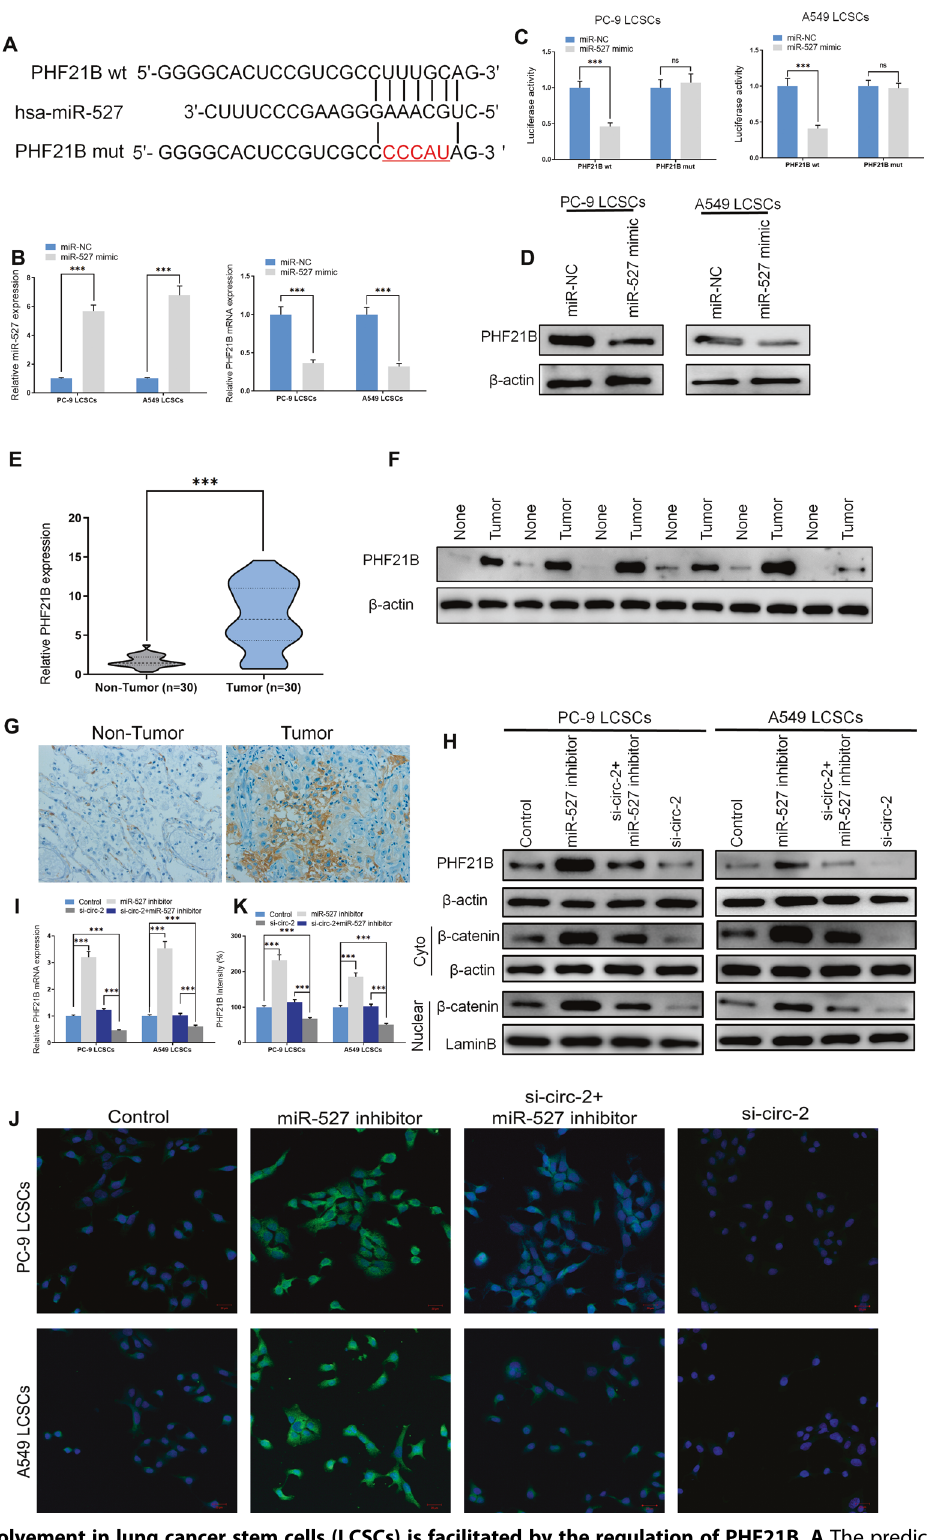
Fig. 5 miR-527 involvement in lung cancer stem cells (LCSCs) is facilitated by the regulation of PHF21B. A The predicted binding sites of miR-527 in PHF21B. The mutated (Mut) version of PHF21B is also presented. B Relative luciferase activity was measured 48 h after transfection in PC9 and A549 LCSCs. C RT-qPCR demonstrating miR-527 and PHF21B levels in LCSCs. D Western blot demonstrating PHF21B level in PC9 and A549 LCSCs. E RT-qPCR demonstrating PHF21B level from 30 NSCLC tumor tissues and adjacent non-tumor tissues. F Western blot demonstrating PHF21B level in 30 NSCLC tumor tissues and adjacent non-tumor tissues. G Immunohistochemistry of PHF21B level in 30 NSCLC tumor tissues and adjacent non-tumor tissues. H RT-qPCR demonstrating miR-527 and PHF21B levels in PC9 and A549 LCSCs. I Western blot demonstrating PHF21B and β -catenin levels in PC9 and A549 LCSCs. J , K Immuno fl uorescence demonstrating PHF21B level in PC9 and A549 LCSCs. Data were shown as mean ± SD; *** P < 0.001. Cell Death and Disease (2021)